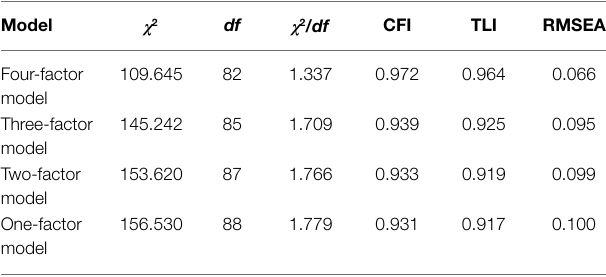
TABLE 3 | Results of confirmatory factor analysis of the measurement